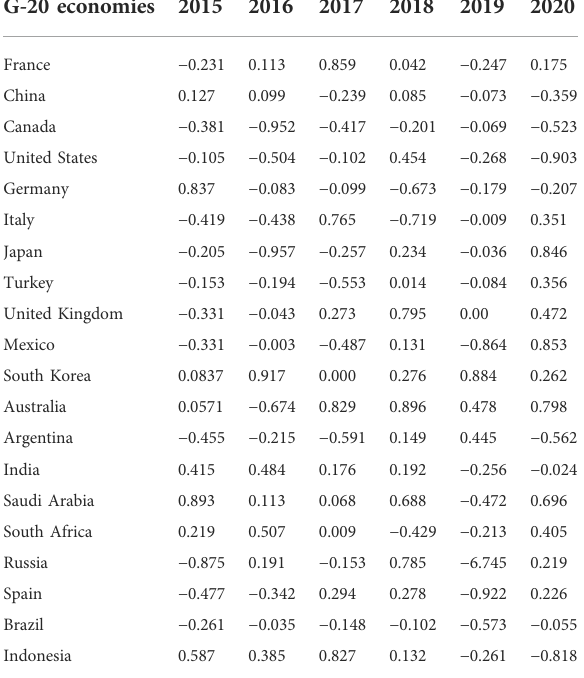
TABLE 4 Impact of energy prices risk on energy ef fi ciency in sample